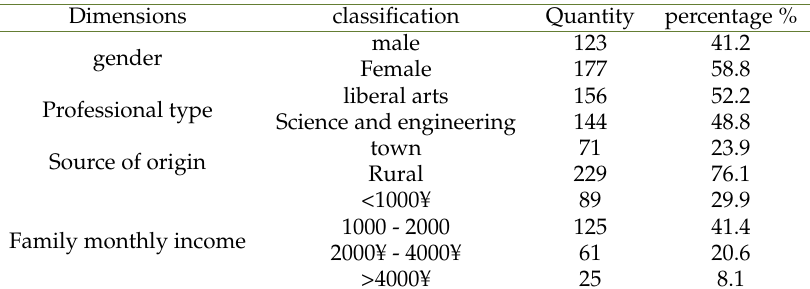
Table 1. Details of the investigators’ composition of the questionnaire.